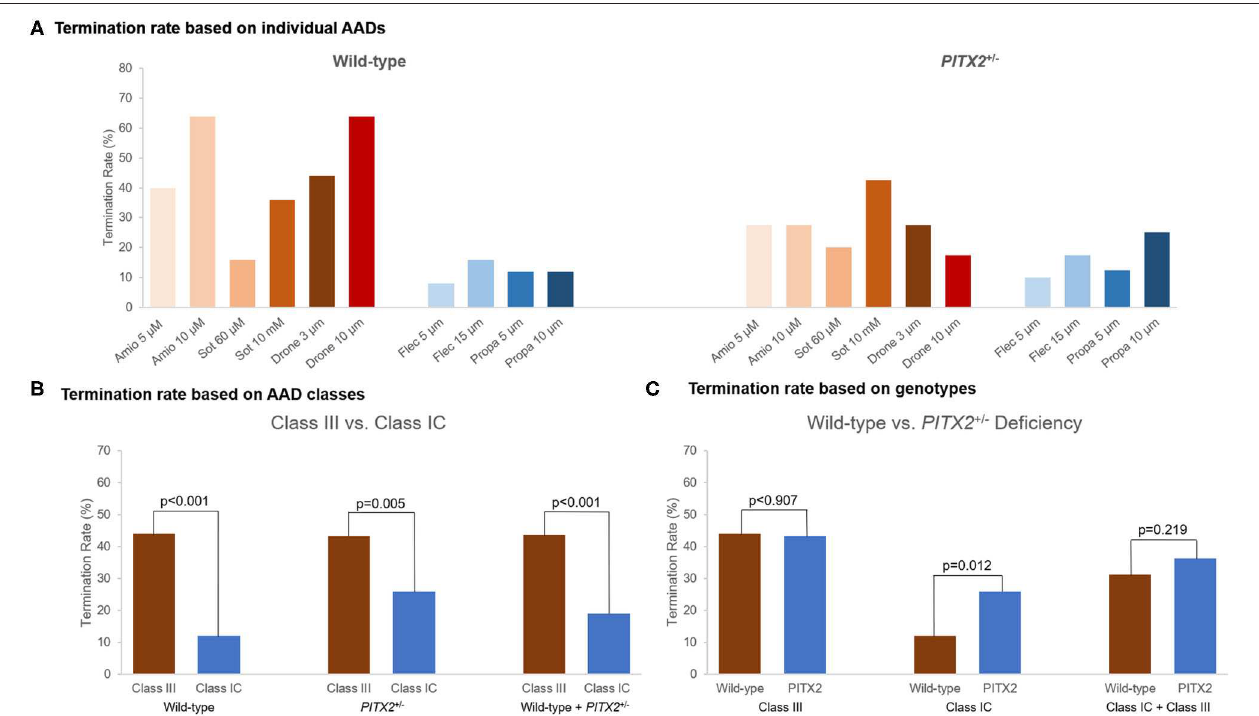
FIGURE 4 | Termination rate of the wild-type and PITX2 + / − deficiency based on the AADs. (A) Termination rate for different AADs was described. (B,C) Termination rate was compared between the wild-type and PITX2 + / − deficiency and class III and class IC. (B) Class III showed higher AF termination rate compared with class IC. (C) Class IC AADs in PITX2 + / − deficiency indicated the higher AF termination rate compared with the wild type. Class III showed the higher termination rate than class IC.